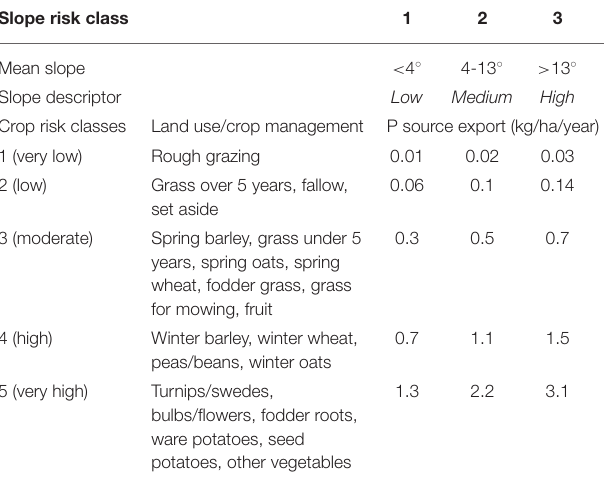
TABLE 3 | Crop class and slope derived P source exports applied to field P